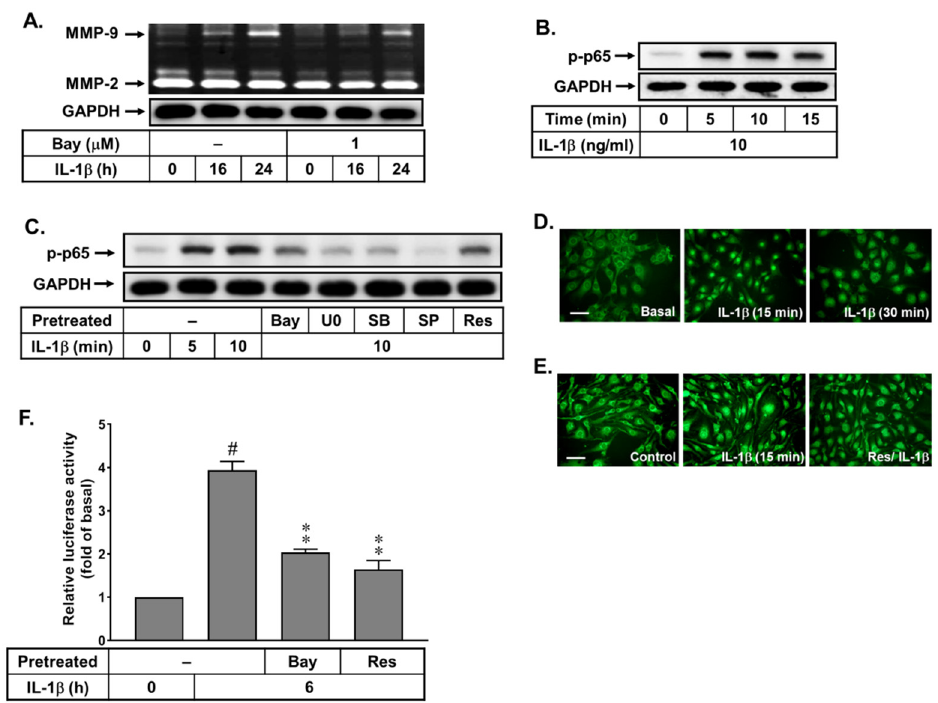
Figure 5. Effects of resveratrol on IL-1 β -induced MMP-9 expression via activation of NF- κ B in bEnd.3 cells. ( A ) Cells were pretreated with Bay11-7082 (Bay, 1 μ M) and then incubated with IL-1 β (10 ng/mL) for the indicated times. The conditioned media were collected and analyzed as described in Figure 1. ( B ) Time dependence of IL-1 β increased phosphorylation of NF- κ B; cells were treated with 10 ng/mL IL-1 β for the indicated time intervals. ( C ) Cells were pretreated with Bay (1 μ M), U0126 (U0, 1 μ M), SB (30 μ M), SP (10 μ M), and Res (1 μ M) for 1 h and then stimulation with IL-1 β (10 ng/mL) for the indicated time intervals. The cell lysates were collected and analyzed phosphorylation of p65 NF- κ B (p-p65) ( B , C ) and GAPDH ( A – C ) by Western blot, as described in Methods. ( D ) IL-1 β stimulates nuclear translocation of NF- κ B; cells were stimulated with 10 ng/mL IL-1 β for the indicated time intervals. ( E ) Cells were pretreated with Res (1 µ M) for 1 h and then were stimulated with IL-1 β for 15 min. Cells were fixed and labeled with anti-p65 NF- κ B antibody and a fluorescein isothiocyanate (FITC)-conjugated secondary antibody. Individual cells were imaged (( D , E ), scale bar = 50 µ m), as described in Methods. ( F ) Quantitative data were analyzed by one-way ANOVA, as described in Methods. Data are expressed as the mean ± SEM ( n = 3); # p < 0.01, as compared with the untreated control; ** p < 0.01, as compared with the cells stimulated with IL-1 β only. The image represents one of three individual